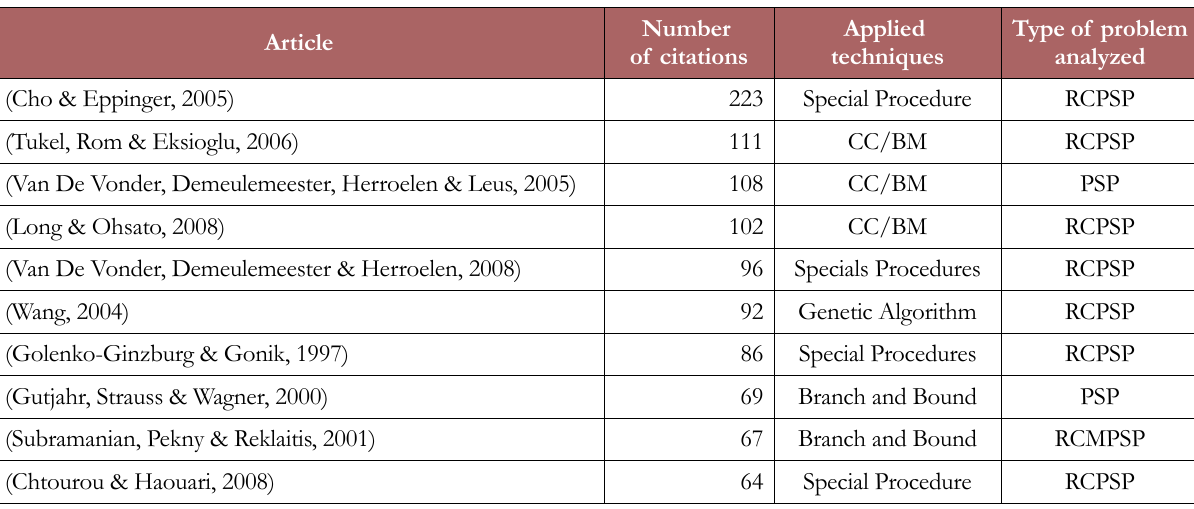
Table 4. Ten most cited articles